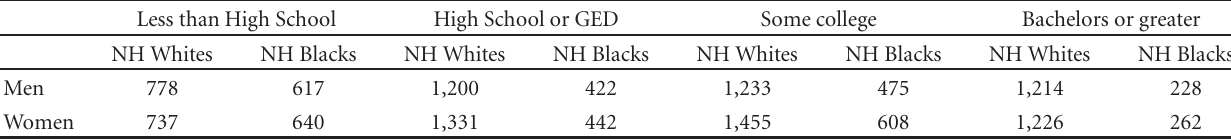
Table 1: Un-weighted sample sizes by gender, education, and race-ethnic group, United States (1999–2006).